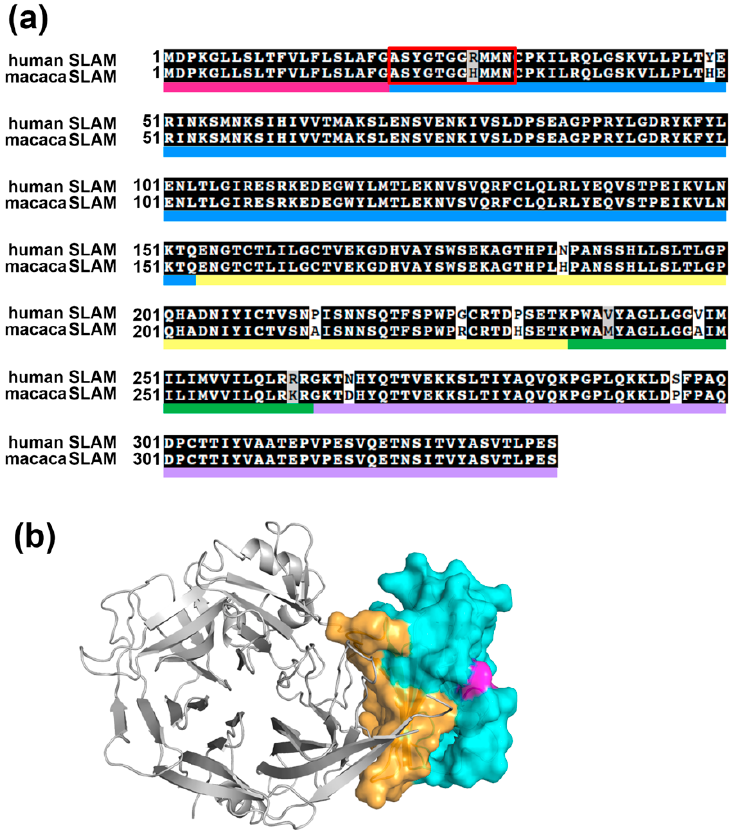
Figure 1. ( a ) Sequence alignment of human signaling lymphocytic activation molecule (SLAM) and macaca SLAM. GenBank accession numbers for human SLAM and macaca ( Macaca mulatta ) SLAM were NP_003028 and XM_001117605, respectively. The alignment was performed by ClustalW. Signal peptides of SLAM were predicted by SignalP. SLAM has five domains: signal peptide (pink), V domain (blue), C2 domain (yellow), transmembrane domain (green) and cytoplasmic domain (purple). ( b ) Overall structure of MV-H (gray cartoon representation) and macaca SLAM (surface representation). Residues at the interaction surface are shown in orange and others are in cyan. Residue 48 (magenta) is not located at the interaction interface (orange).